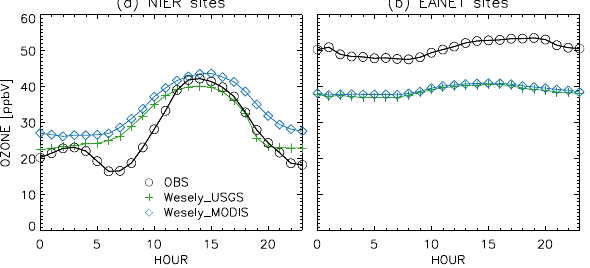
Figure 7. Same as in Fig. 4 but the simulated O 3 concentrations were generated using the USGS (pluses) and MODIS land-use data (diamonds) with the Wesely scheme.